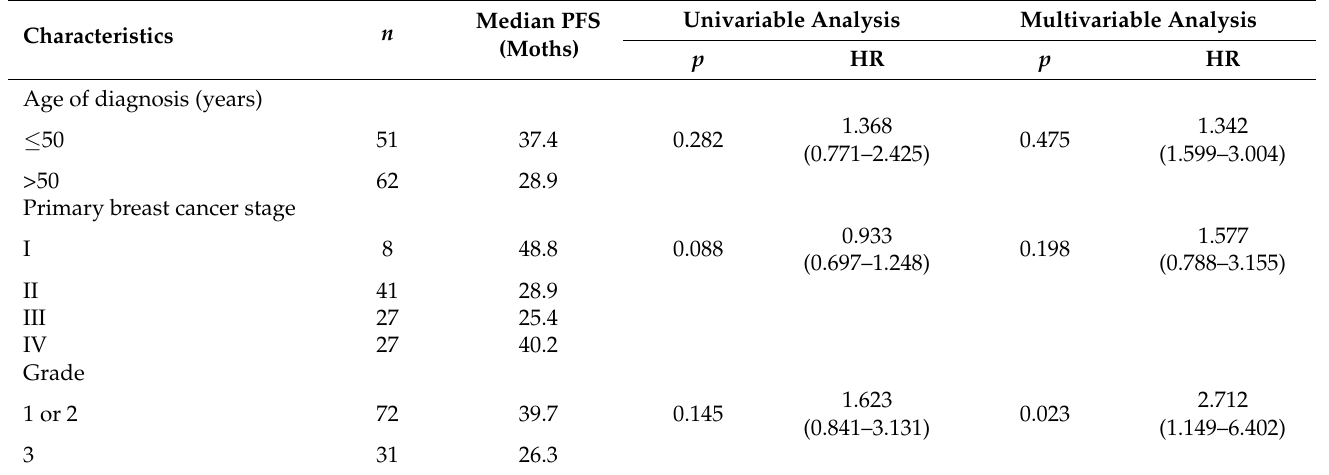
Table 4. Univariable and multivariable analysis of overall